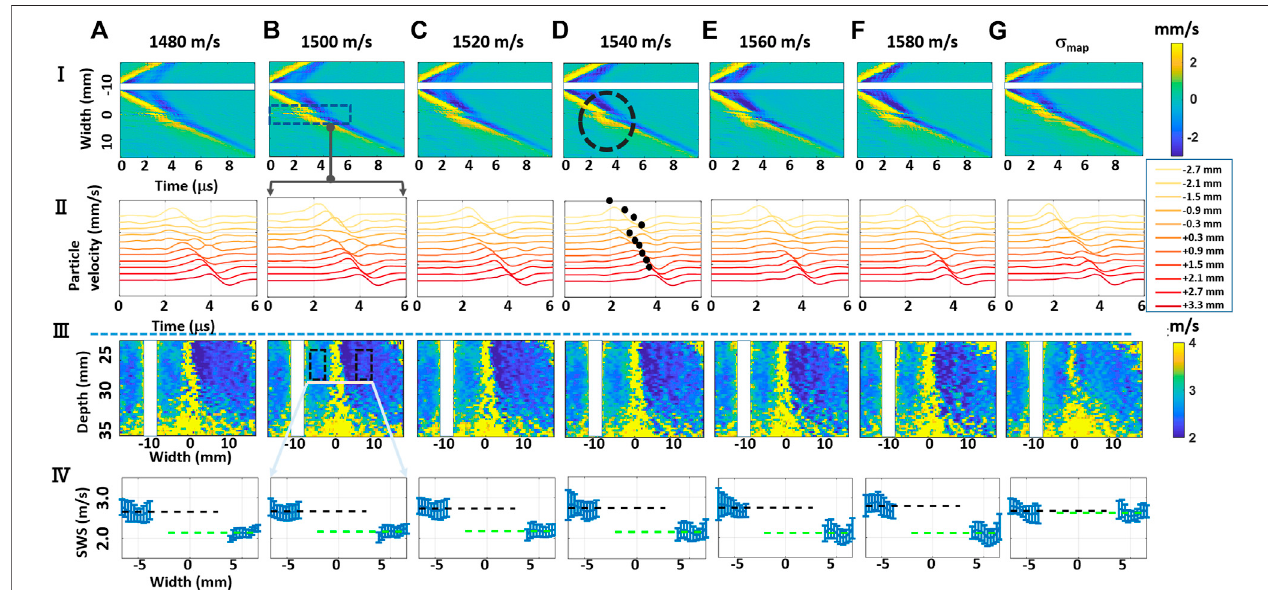
FIGURE3| Experimentalresults. (i) Shear-waveaxialvelocity time and propagation distancepro fi les; (ii) Axial velocity pro fi lescorrespondingtorectangularregion (i,b) ; (iii) resulting shear-wavespeed (SWS) maps; and (iv) SWS pro fi les over selected rectangularregions ofinterest(ROI),withtheerrorbarsrepresenting thestandard deviations of SWS values along the vertical axis, with the dashed lines marking the average of their means, black for the left side and green for the right. Each column shows results for beamforming the same data acquisition with different speed-of-sound (SoS) maps (A – F) for constant SoS maps from 1,480 to 1,580 m/s, and (G) using a spatially varying SoS map σ map . We do not report the results, by masking them in white, within vertical bands around the lateral push locations where the shear-wave travels before the tracking starts.